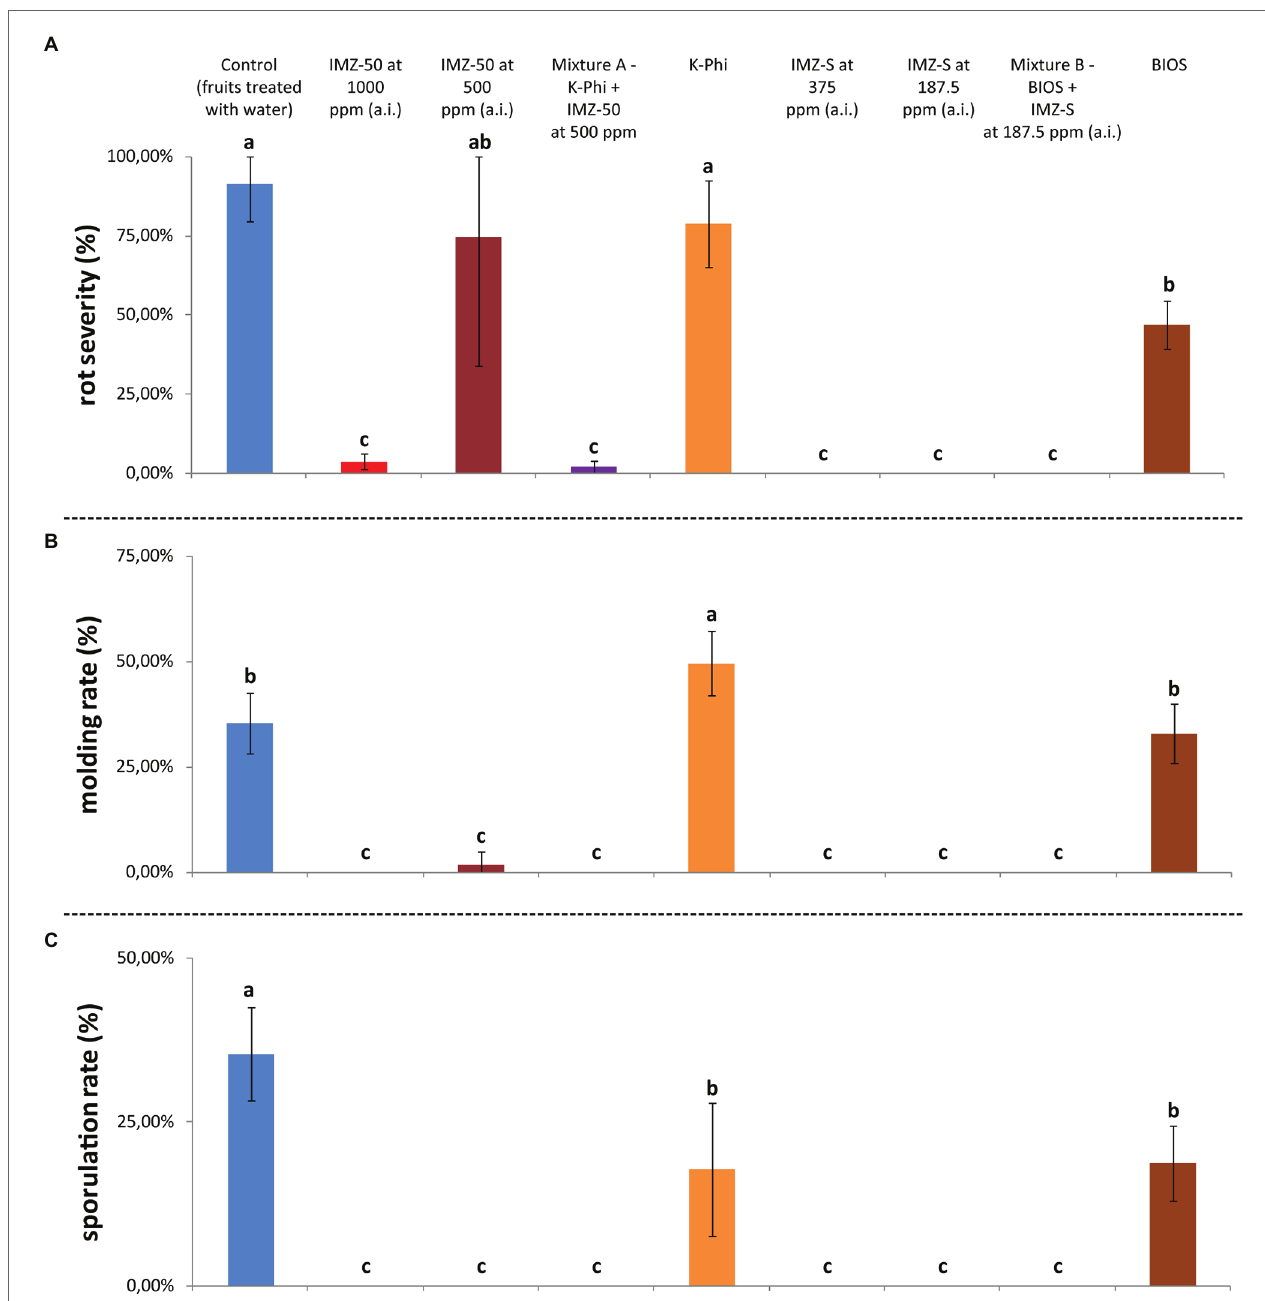
FIGURE 7 | (A) Rot severity (%), (B) molding rate (%), and (C) sporulation rate (%) caused by Penicillium digitatum strain, P_digit_G.B.A., in Citrus sinensis cv. Moro nucellare orange fruits treated with water (control) or IMZ-50 (emulsifiable concentrate formula at 50% w/v of active ingredient - a.i.) at 1,000 ppm or 500 ppm a.i., IMZ-S (formula at 7.5% w/v of a.i.) at 375 ppm or 187.5 ppm a.i., K-Phi formula (57% w/v) at the dosage of 0.25%, BIOS formula at the dosage of 0.15%, Mixture A (K-Phi: 0.25%; IMZ-50: 500 ppm a.i.), and Mixture B (BIOS: 0.15%; IMZ-S: 187.5 ppm a.i.) 5 days after treatment. Values sharing the same letters are not statistically different according to the Tukey’s HSD (Honestly Significant Difference) test ( p ≤ 0.05). Bars represent